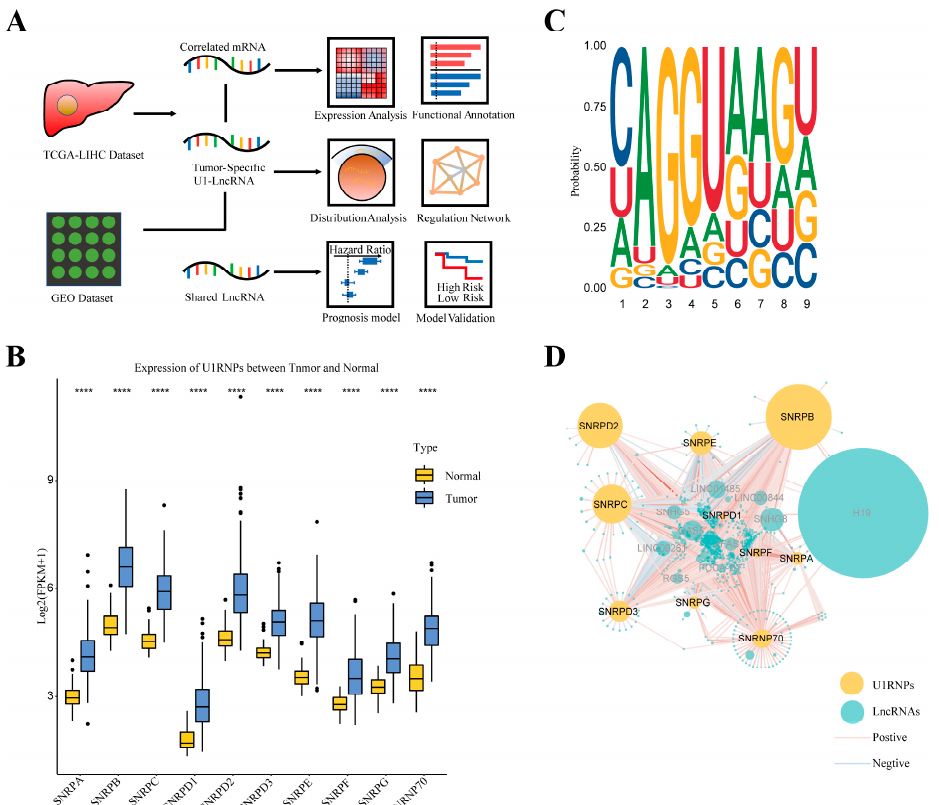
Figure 1. Overview of the U1RNPs and U1-lncRNAs in HCC. ( A ) Flowchart of the study. ( B ) Box plot of the expression level of U1RNPs. The expression of U1RNPs in each sample was normalized by log2(FPKM + 1) and T-test was used for comparison. Significance level: **** p < 0.0001. ( C ) Sequence logo of the U1-binding motif. ( D ) The correlation network of U1RNPs and U1-lncRNAs (The color and width of lines were mapped with the correlation and the size of pies was mapped with the expression level).